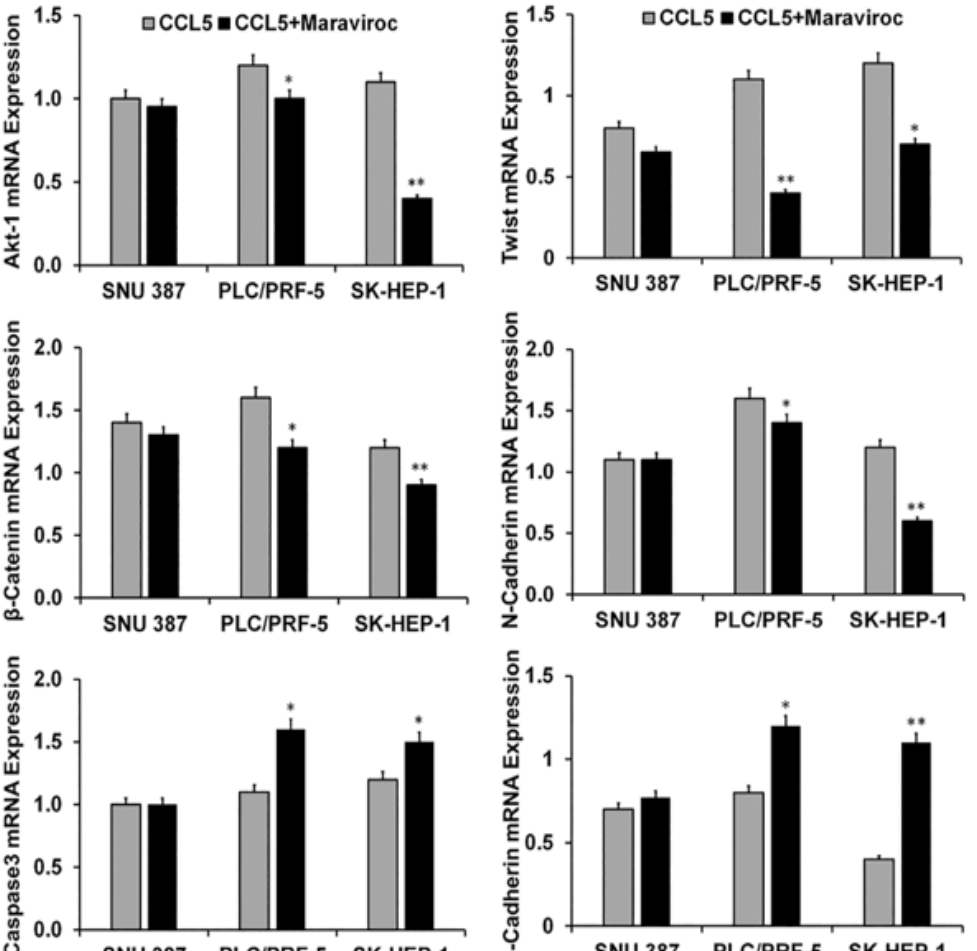
Figure 6. Effect of CCR5 overexpression or inhibition on cell survival, apoptosis, and the EMT in HCC cells. HCC cells were treated with CCL5 with or without maraviroc for 30 min. The bar graphs present the mRNA fold changes in expression of cell survival (Akt-1), apoptosis (caspase-3), and EMT ( β - catenin, Twist, N-cadherin, and E-cadherin) markers. To normalize the data, 18S rRNA was used as an endogenous control. The experiments were repeated three times. Bar graphs are presented as fold change in expression (±standard error); the asterisks indicate p values (* p < 0.05 ** p < 0.01).